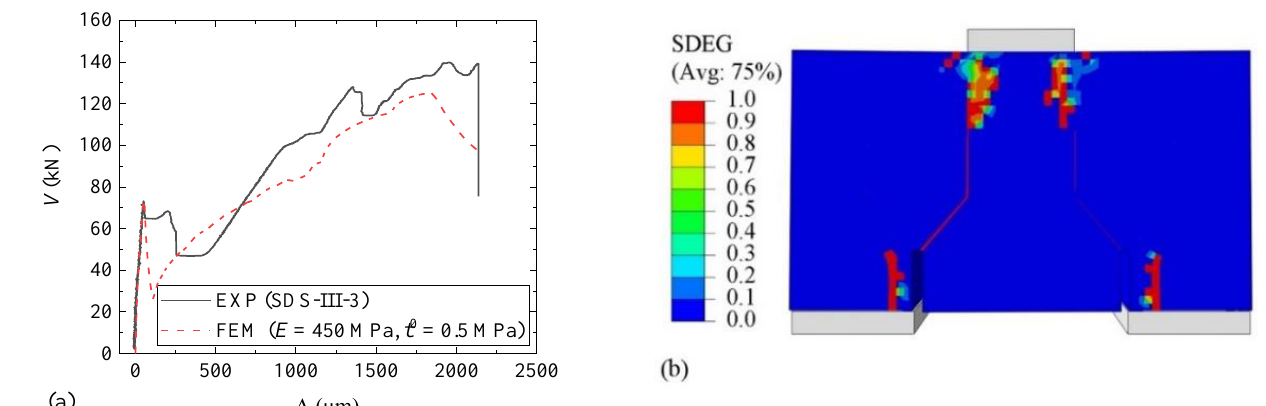
Figure 17. Results for Specimen SDS-III-3: ( a ) V - ∆ curves; ( b ) damage